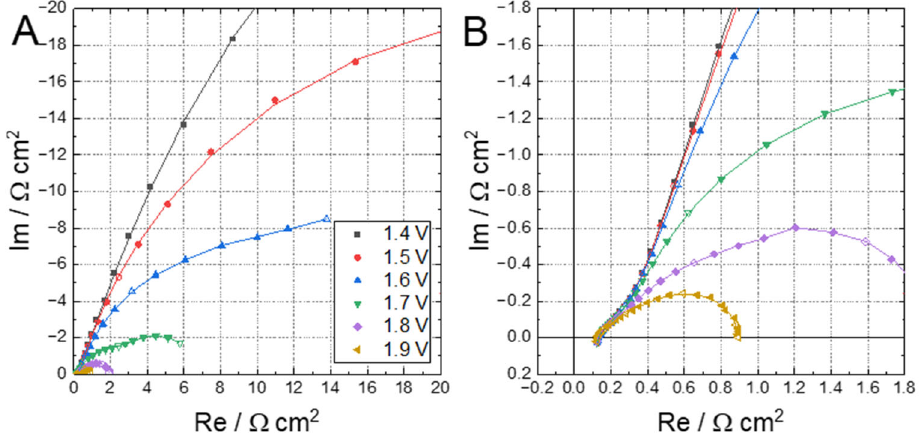
Figure 2. The Nyquist ( A ) plots of AEM water electrolyzer EIS are given. Raw EIS data are given as dots. Reference EIS dots obtained at ca. 0.1, 1.0, 11, 116, 1200, and 8700 Hz are given as open symbols. The Nyquist plots of the lower Re values are given in ( B ).